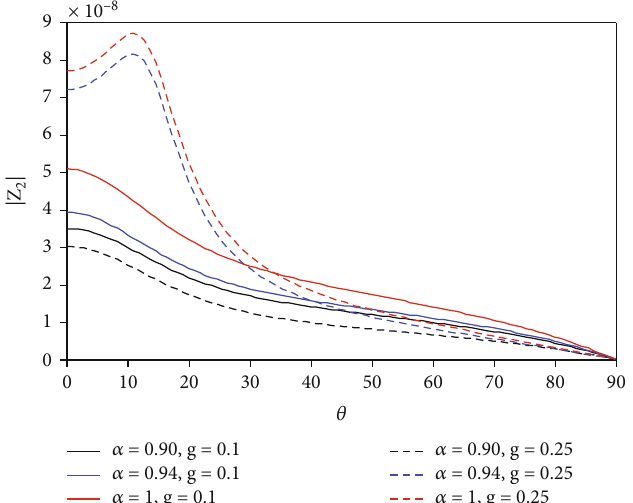
j concerning the angle of incidence θ for various values of the fractional parameter of the 2